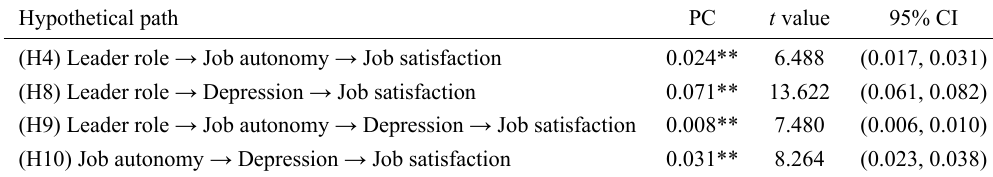
Table 6. Results of hypotheses testing on the mediating effects in non-regular employees.